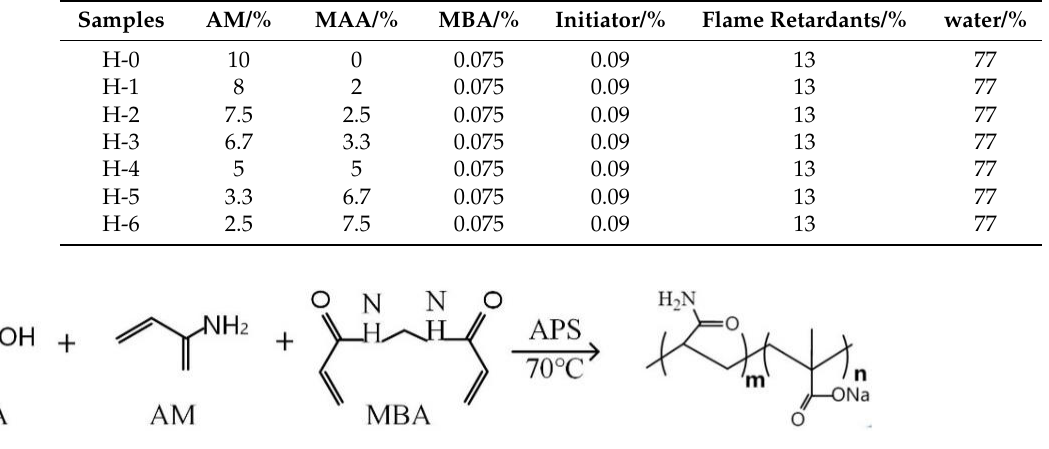
Scheme 1. Synthesis route of P(AA-co-MAA).